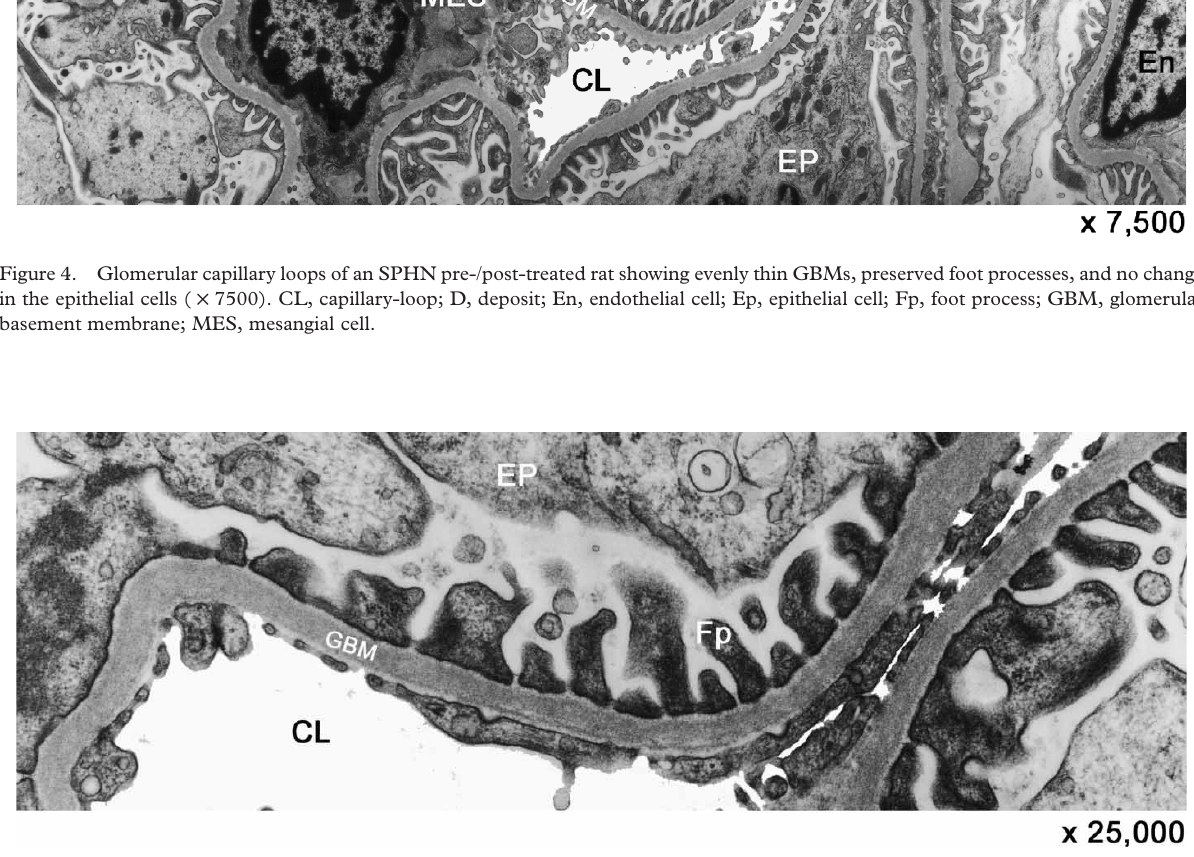
Figure 5. Glomerular capillary loop of an SPHN post-treated-only rat. Evenly thin GBM, well preserved foot processes, and epithelial cells opposite the GBM show no morphological changes ( £ 25,000). CL, capillary-loop; Ep, epithelial cell; Fp, foot process; GBM, glomerular basement membrane.